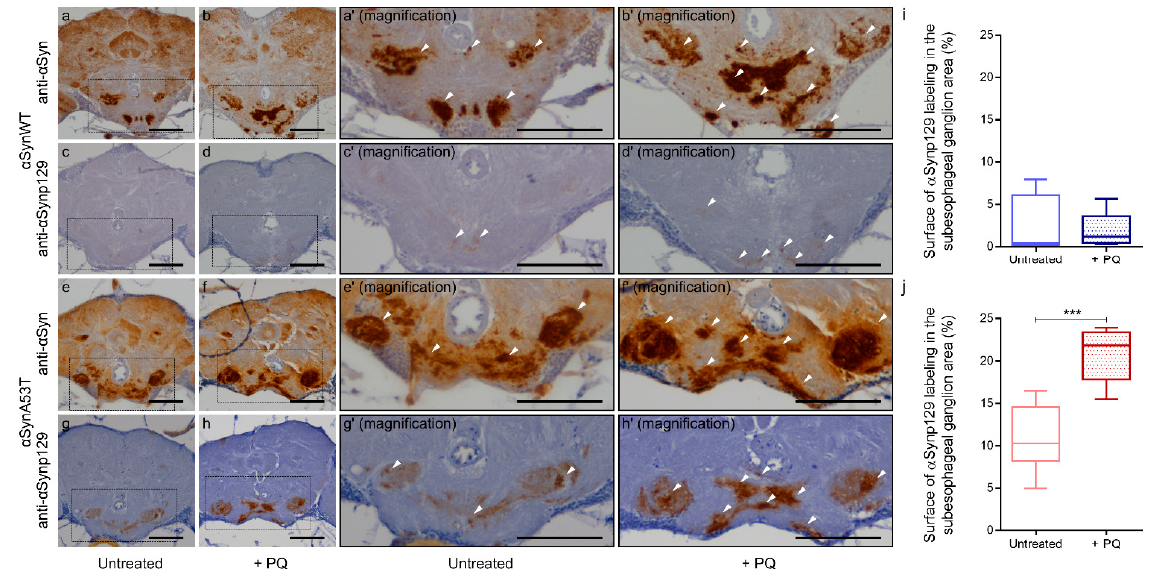
Figure 8. Chronic exposure to Paraquat induces the accumulation of α Synp129. In brains of α SynA53T-expressing flies. Immunohistochemistry was performed using anti- α Syn (MJFR1) ( a , b , e , f ) or anti- α Synp129 (EP1536Y) ( c , d , g , h ) antibodies on paraffin-embedded brain sections of α SynWT ( a – d ) or α SynA53T ( e – h ) expressing flies untreated or exposed to PQ (+PQ) at LT50. Magnification of area indicated in ( a – d ) are shown in ( a’ – d’ ). Magnification of area indicated in ( e – h ) are shown in ( e’ – h’ ). White arrowheads indicate α Syn or α Synp129 deposits. The scale bar is 30 µm. Quantifications show the surface of α Synp129 (EP1536Y) labeling in subesophageal ganglion area for α SynWT ( i ) or α SynA53T ( j ) in control (untreated) or PQ exposed (+PQ) flies. In the box and whisker plots in ( i , j ), boxes extend from the first to the third quartile, the line inside the boxes shows the median and the whiskers represent the min/max value of 10 independent experiments: α SynWT (n = 4 for untreated, n = 5 for PQ) or α SynA53T (n = 8 for untreated, n = 10 for PQ). p -values of the group differences were calculated using the Mann–Whitney test (*** p = 0.0002).